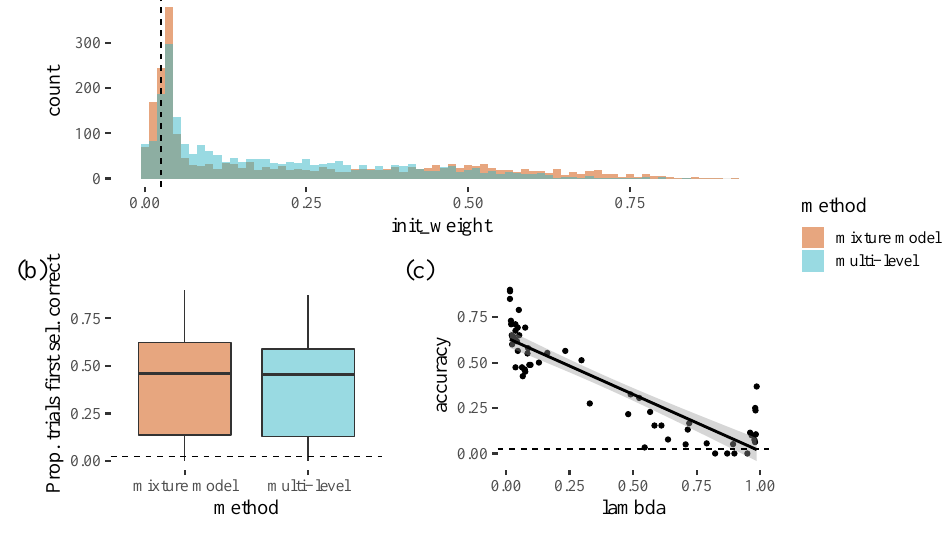
Figure 8. ( a ): a count of initial weight values predicted from both methods (mixture and multi-level). ( b ): the proportion of times the first selection was correct for both methods. ( c ): as lambda (the model parameter underlying initial weight) increases, accuracy increases i.e., the model is more accurate for the cases where participants are selecting a corner as their initial target selection. The dots each represent an individual participant, and the line is the line of best